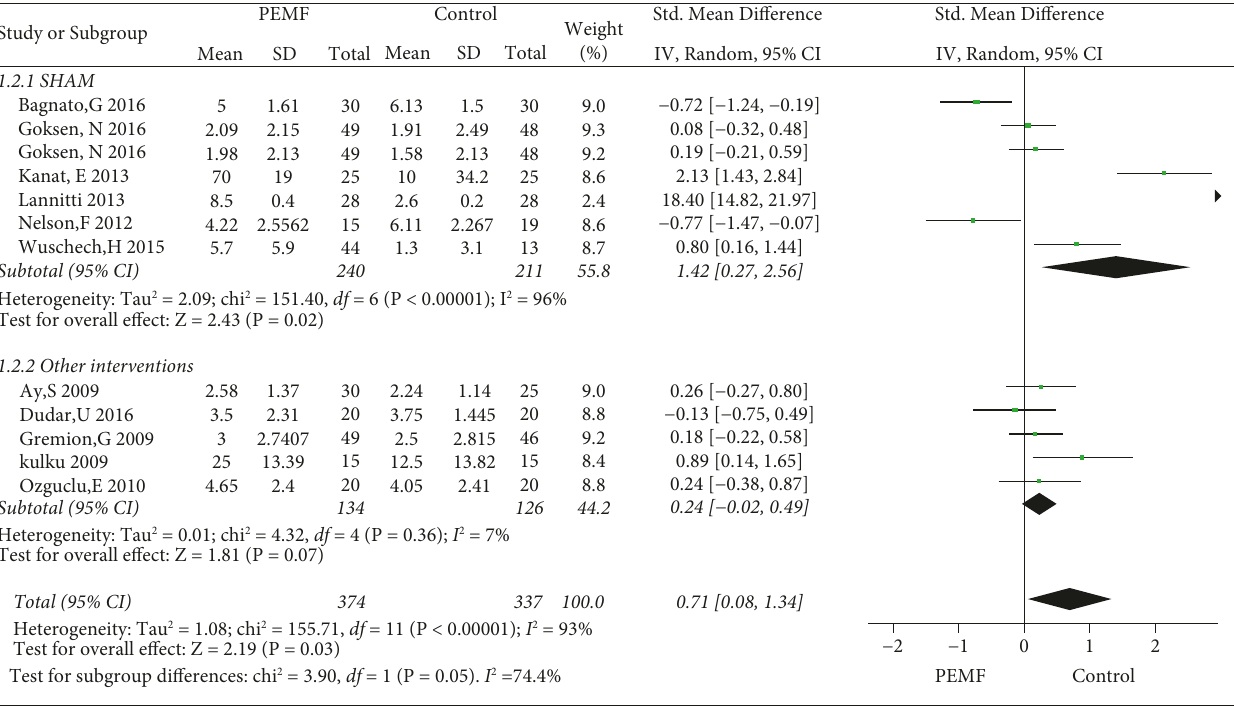
Figure 5: Forest plots representing the effect of PEMF versus control therapies in pain and subgroup analysis basing on different type of control